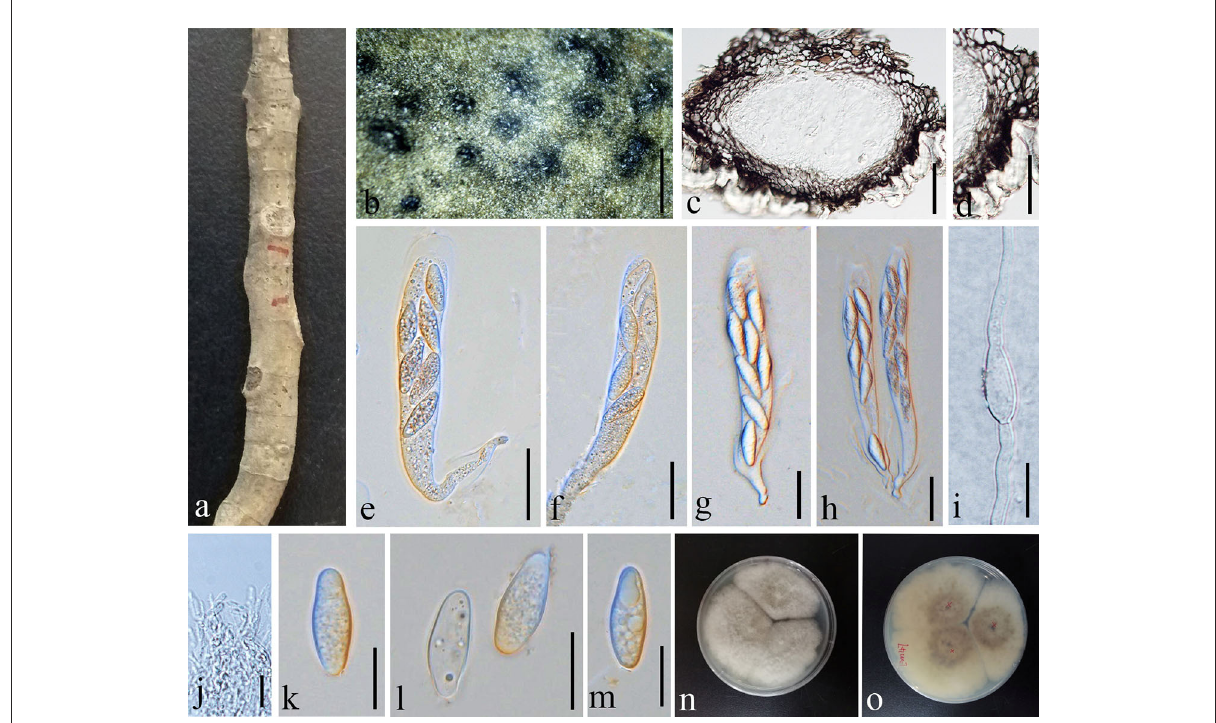
FIGURE4 Botryosphaeria dothidea (GMB1387, new host record from China). (a) Host material. (b) Appearance of ascomata on the host. (c) Vertical section of ascoma. (d) Peridium. (e–h) Asci. (i) Germinating ascospore. (j) Pseudoparaphyses. (k–m) Ascospores. (n) Culture on PDA from above. (o) Culture on PDA from the bottom. Scale bars: (b) = 1,000, (c) = 50, (d) = 25, (e–h) = 30, (i,k–m) = 15, and (j) = 10 µ